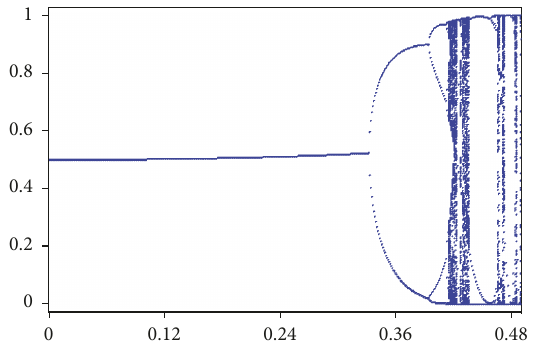
Figure 5: The bifurcation diagram of 𝑓 with respect to Δ ∈ (0,0.49] , for 𝑤 𝑥 = 𝑤 𝑦 = 1 , 𝑎(0) = 0.5